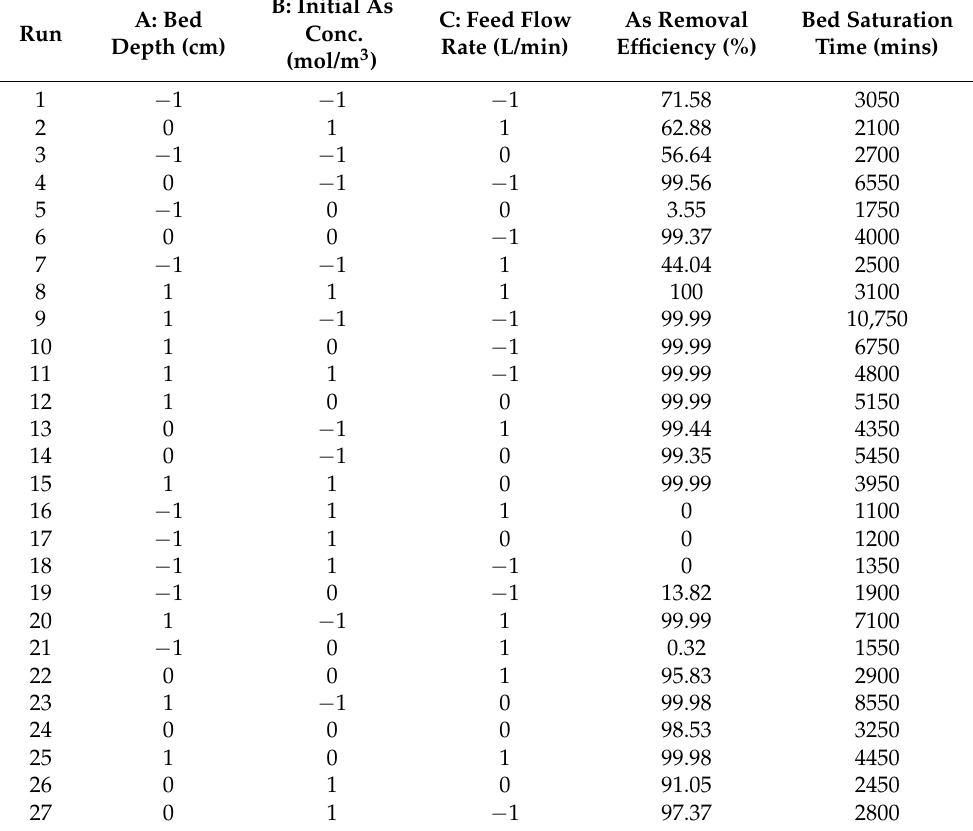
Table 4. Factors design matrix and responses.